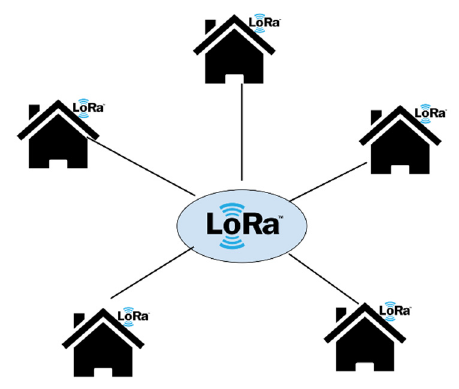
Figure 5. Architecture of LoRa technology.